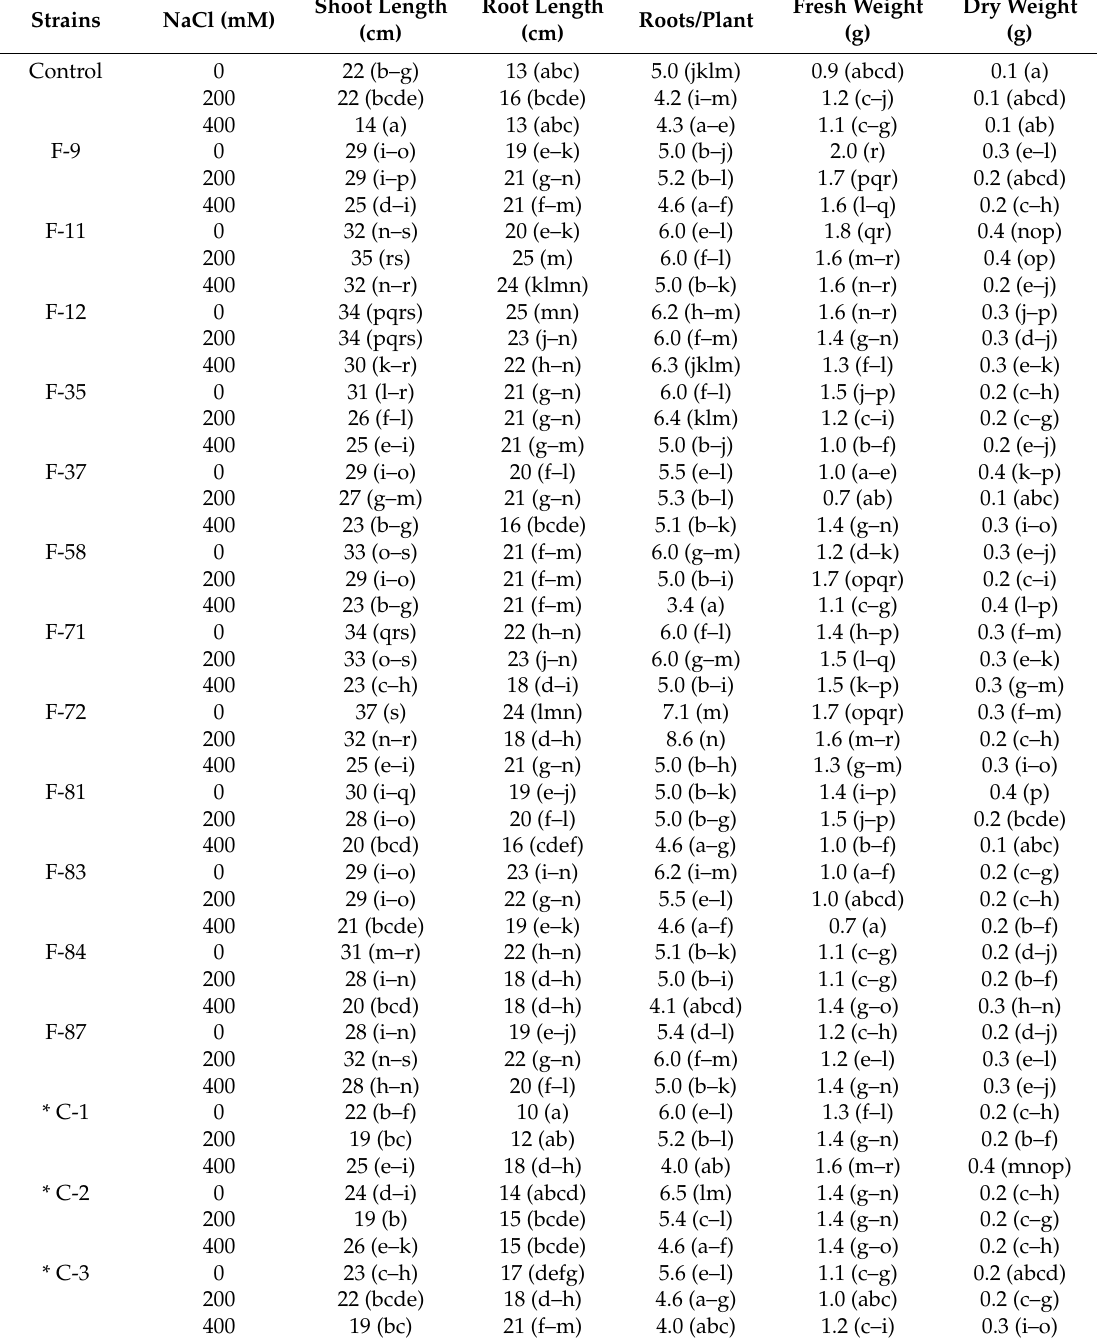
Table 5. Effect of halotolerant bacterial strains on the growth of Z. mays in salt amended soils.